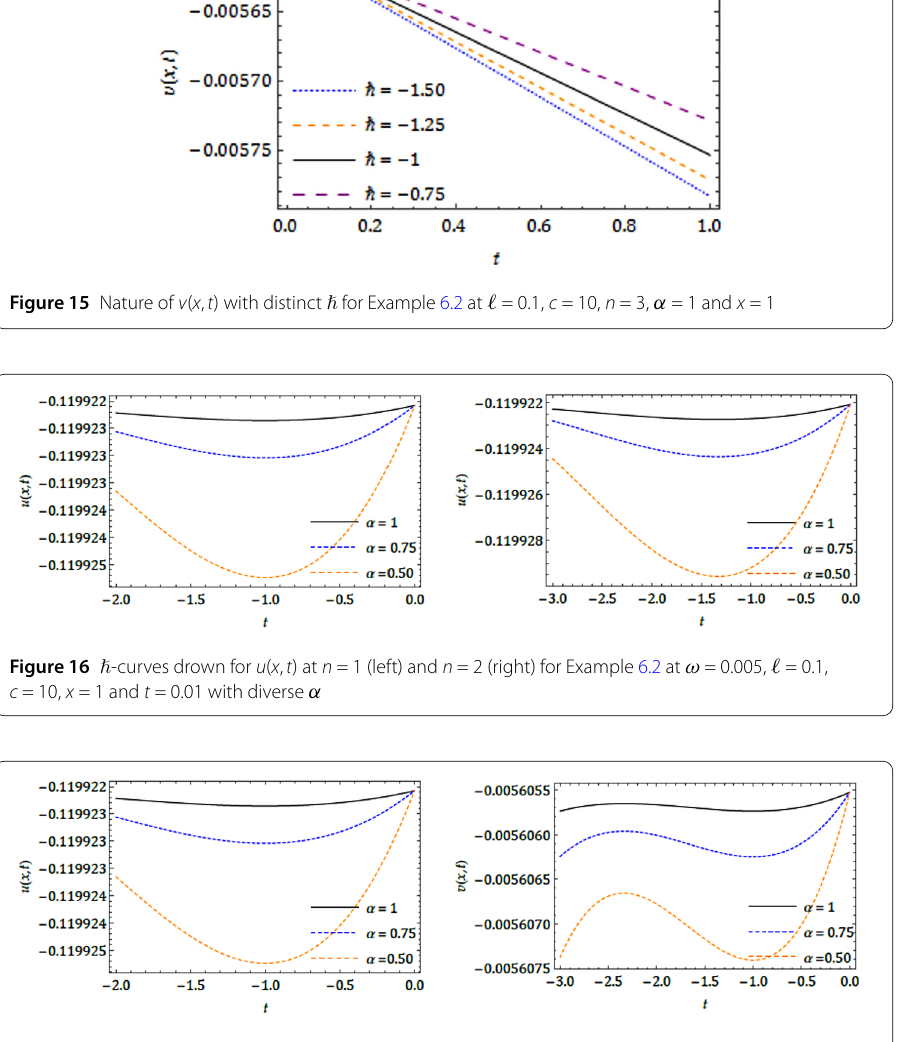
Figure 17 (cid:2) -curves drown for v ( x , t ) at n = 1 (left) and n = 2 (right) with different α for Example 6.1 when ω = 0.005, (cid:13) = 0.1, c = 10, x = 1 and t =